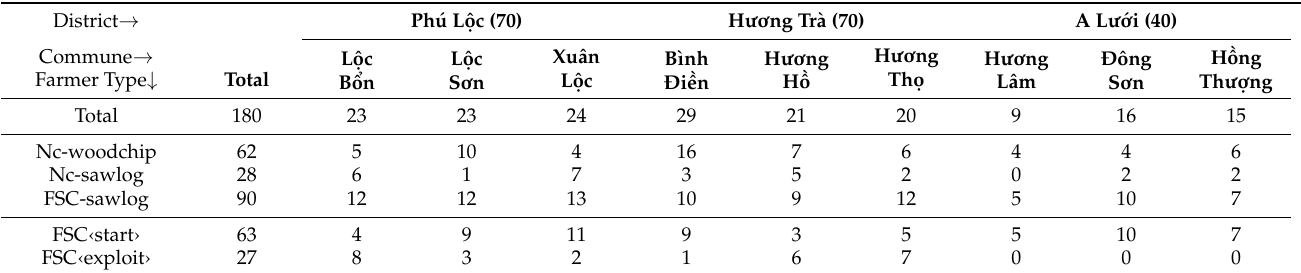
Table 1. The number of respondents interviewed in the communes of the three study districts, i.e., Ph ú L ộ c, H ươ ng Tr à and A L ướ i by farmer type, i.e., producers of non-certified woodchips only (Nc-woodchip), non-certified sawlogs (Nc-sawlog), and FSC-certified sawlogs which had (FSC‹exploit›) or had not yet (FSC‹start›) been exploited on some plots. District